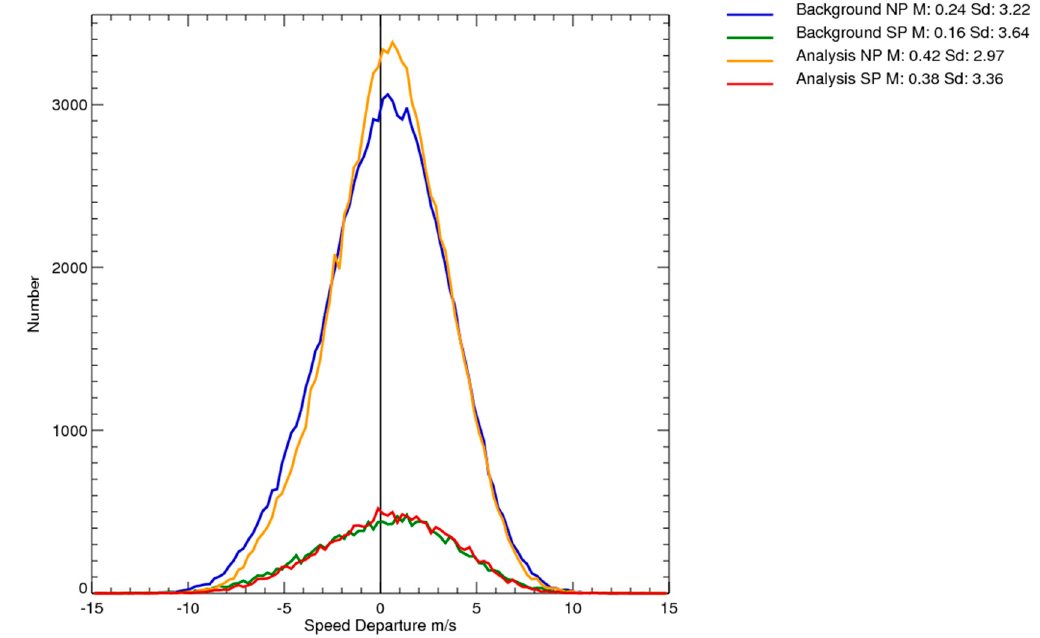
Figure 10. Distribution of speed departure for 01–29 July 2012 for the AIRS moisture AMVs. Compared to the background (Arctic - blue; Antarctic - green) and analysis (Arctic–yellow; Antarctic –red).